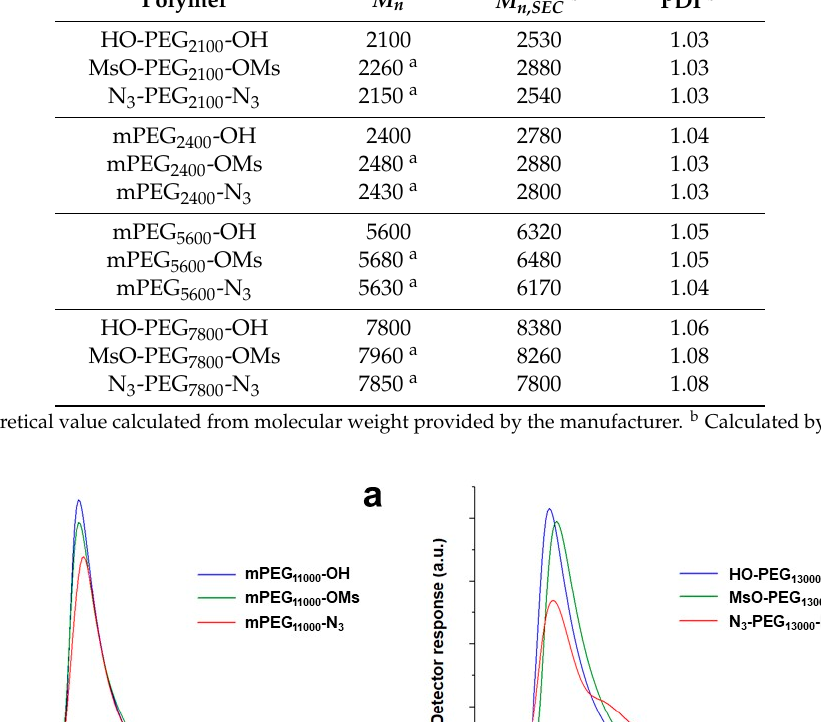
Figure 5. Dependence of T m and X c on the molecular weight of neutral PEG, mPEG-N 3 and N 3 - PEG-N 3 series.